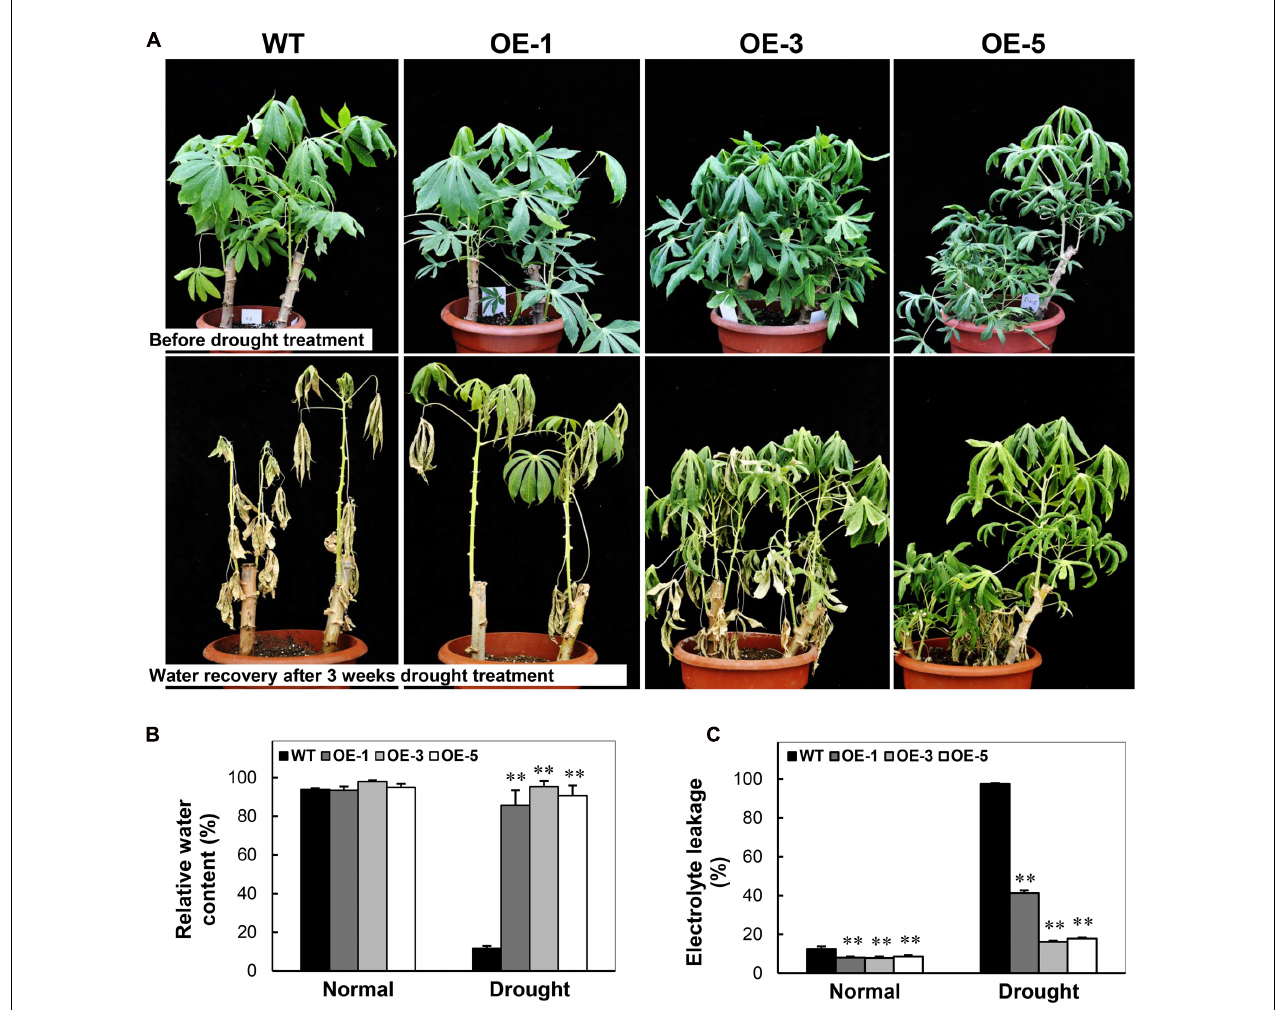
FIGURE 7 | Performance of Arabidopsis CBF3 overexpressing cassava in response to drought. (A) 3-month-old pot-grown plants in the greenhouse before and after drought treatment, i.e., withheld water for 3 weeks. (B,C) Relative water content (B) and electrolyte leakage (C) of the WT and OE lines under normal and drought stress. Data are presented as mean ± SD of three independent assays; asterisks indicate significant differences compared with the WT at ∗∗ P < 0.01 by Student’s t